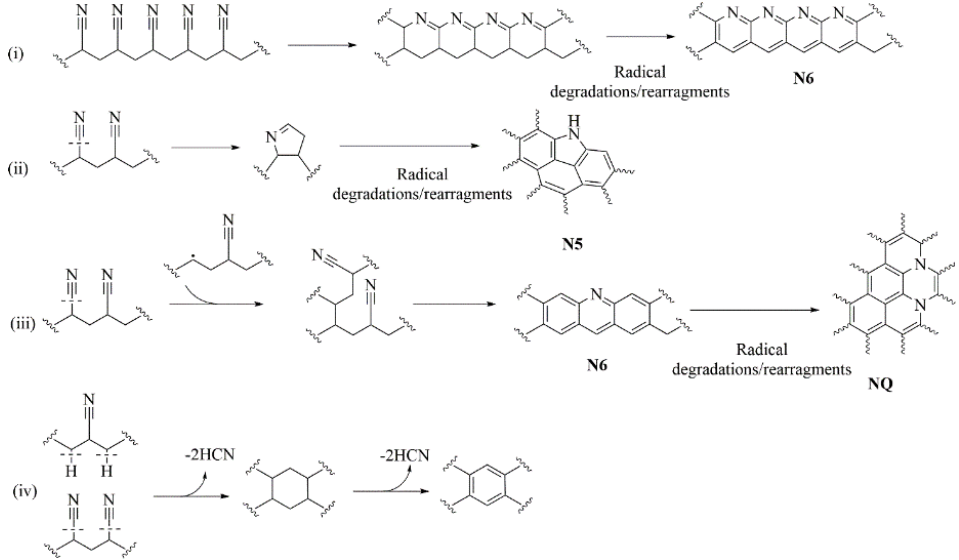
Figure 3. Proposed mechanism for ( i ) N6, ( ii ) N5, ( iii ) NQ and ( iv ) aromatic rings formation occurring during stabilization and carbonization of PAN fibers.